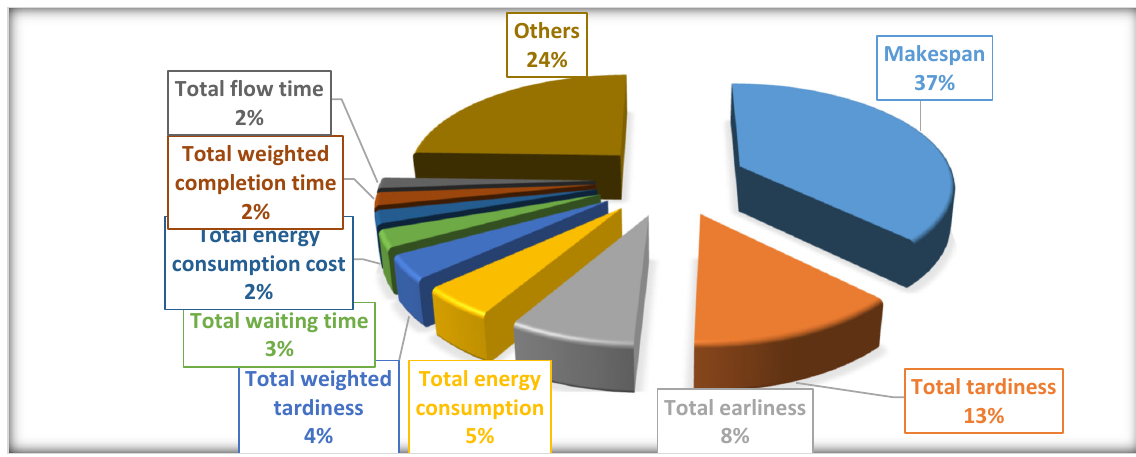
Fig. 12. Percentage distribution of objective functions for